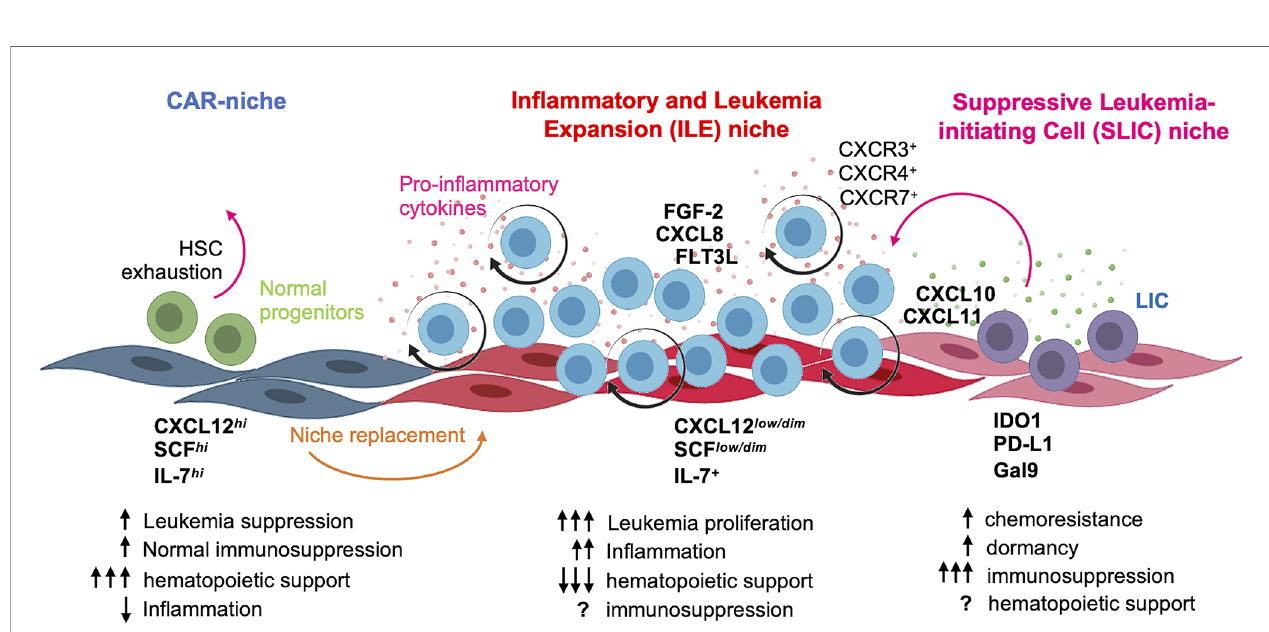
FIGURE 8 | Concluding model. At leukemia debut, B-ALL blasts hijack and remodel CAR niche by inducing CXCL12 and SCF downregulation, concomitant to proin fl ammatory cytokine production and followed by the emergence of a LIC-supporting niche endowed with suppressor properties. The functional identity of normal CAR niche and the suggested in fl ammatory and leukemia expansion (ILE) and suppressive leukemia-initiating cell (SLIC) hematopoietic niches are highlighted. Figure was created using BioRender templates.